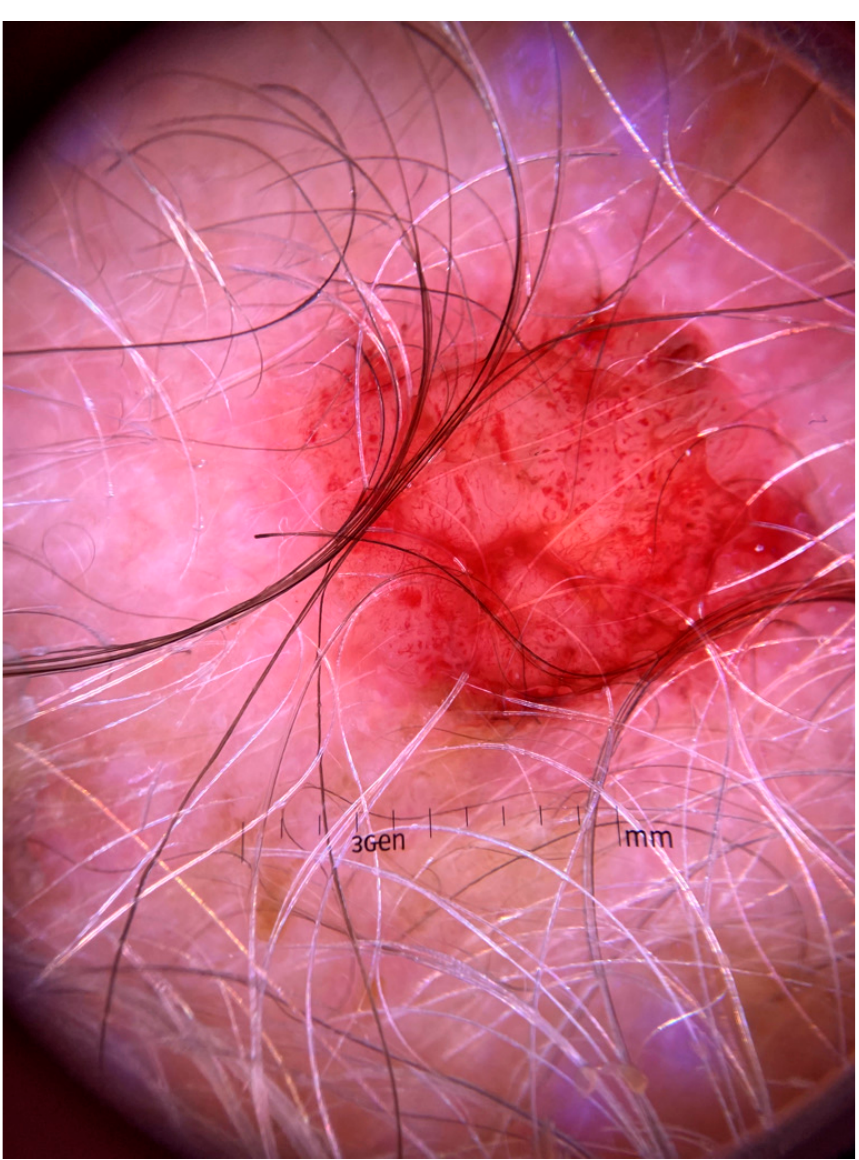
Figure 2. Dermoscopic picture of eccrine porocarcinoma exhibiting an atypical vascular pattern with polymorphous vessels and pink-whitish ovoid areas.